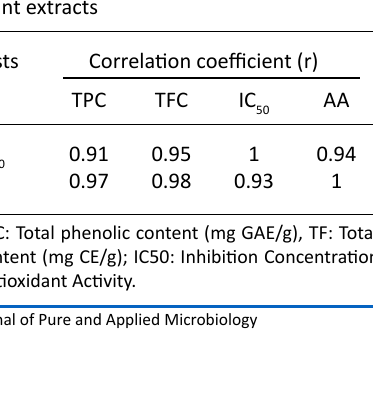
Table 7. Correlation matrix between phenolic compounds and antioxidant activities of methanolic plant extracts Tests